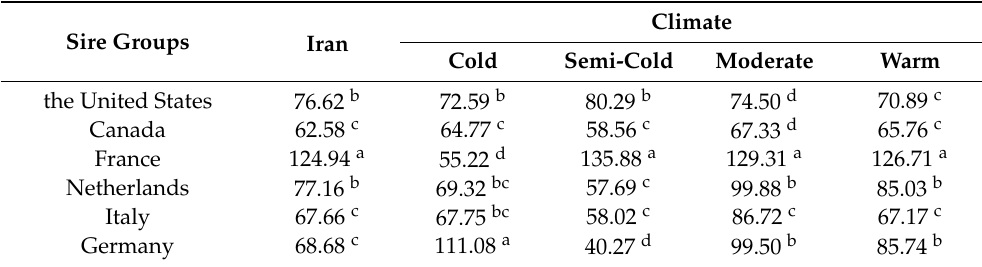
Table 5. Comparison of least-square means of Lifetime Net Income (LNI) index for production and re- production traits between daughters from different sire groups in Iran and its various climates